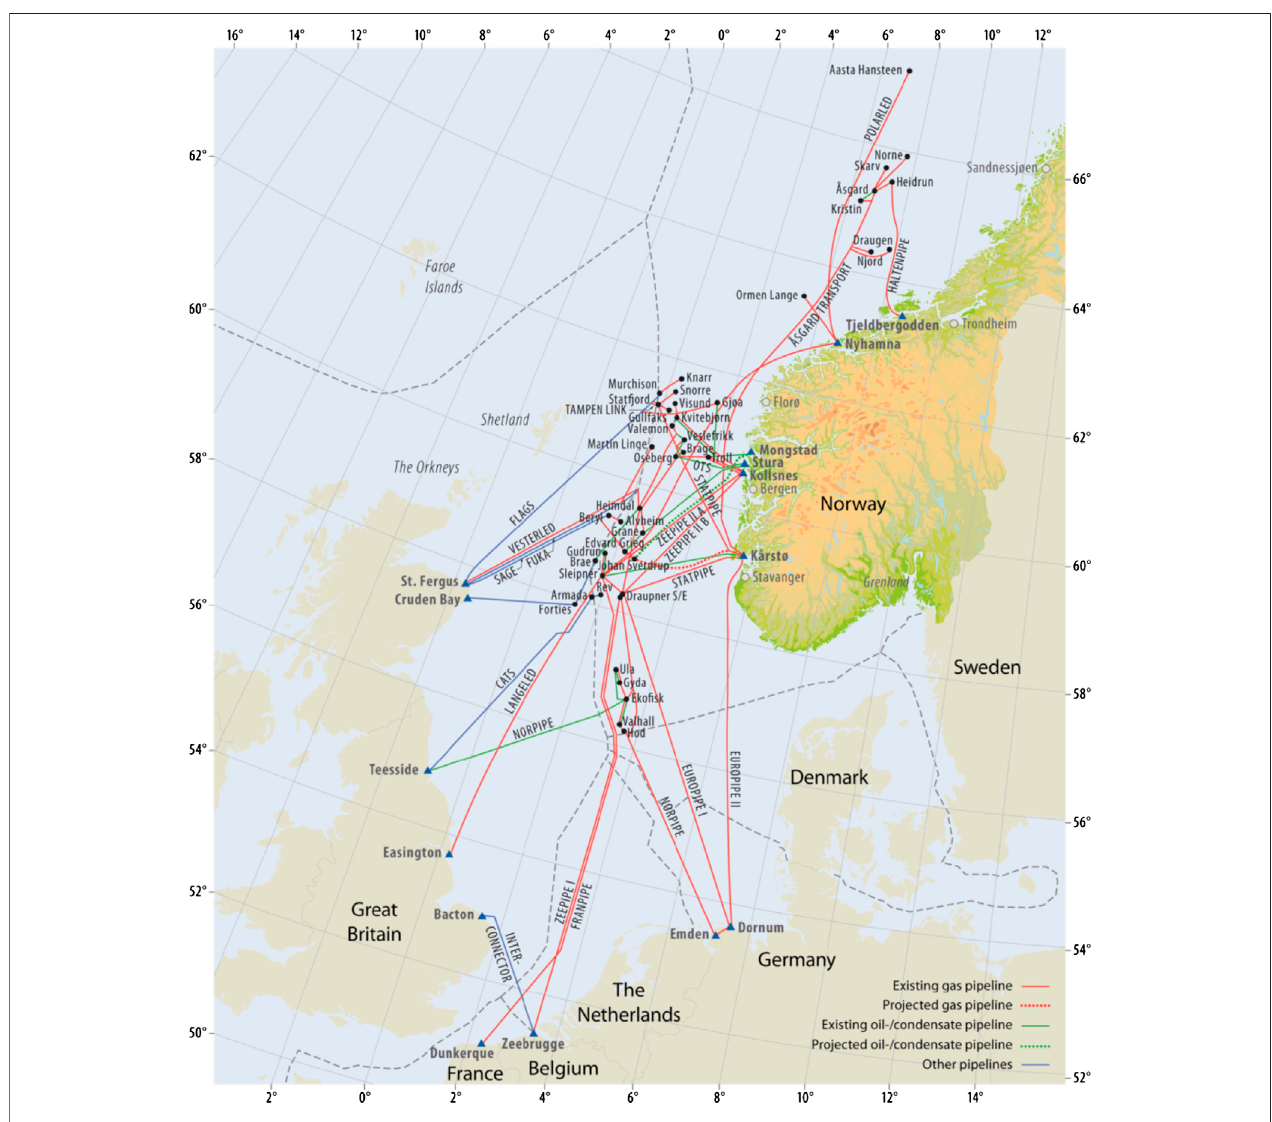
FIGURE 4 | Platforms and pipelines on the Norwegian continental shelf. The picture shows assets of more than one company [20].